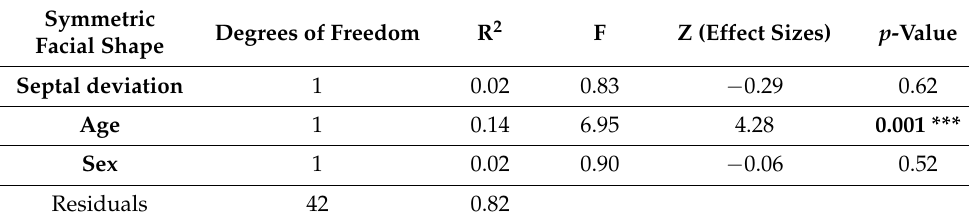
Table 5. Results of the Multivariate Procrustes ANOVA between the dependent variable of symmetric facial shape and the independent variables of septal deviation (relative values), age, and sex. Asterisks indicate significance: * p -value ≤ 0.05; ** p -value ≤ 0.01; *** p -value ≤ 0.001.